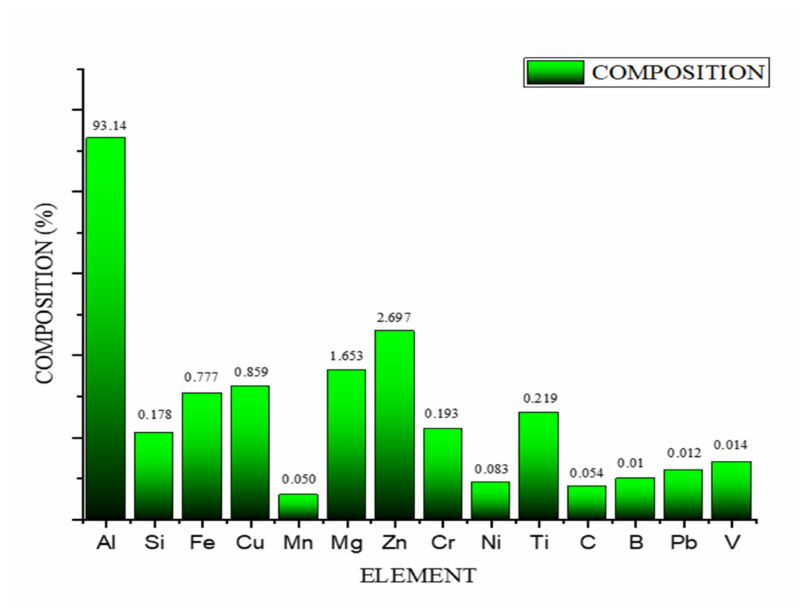
Figure 5. Spectroscopy